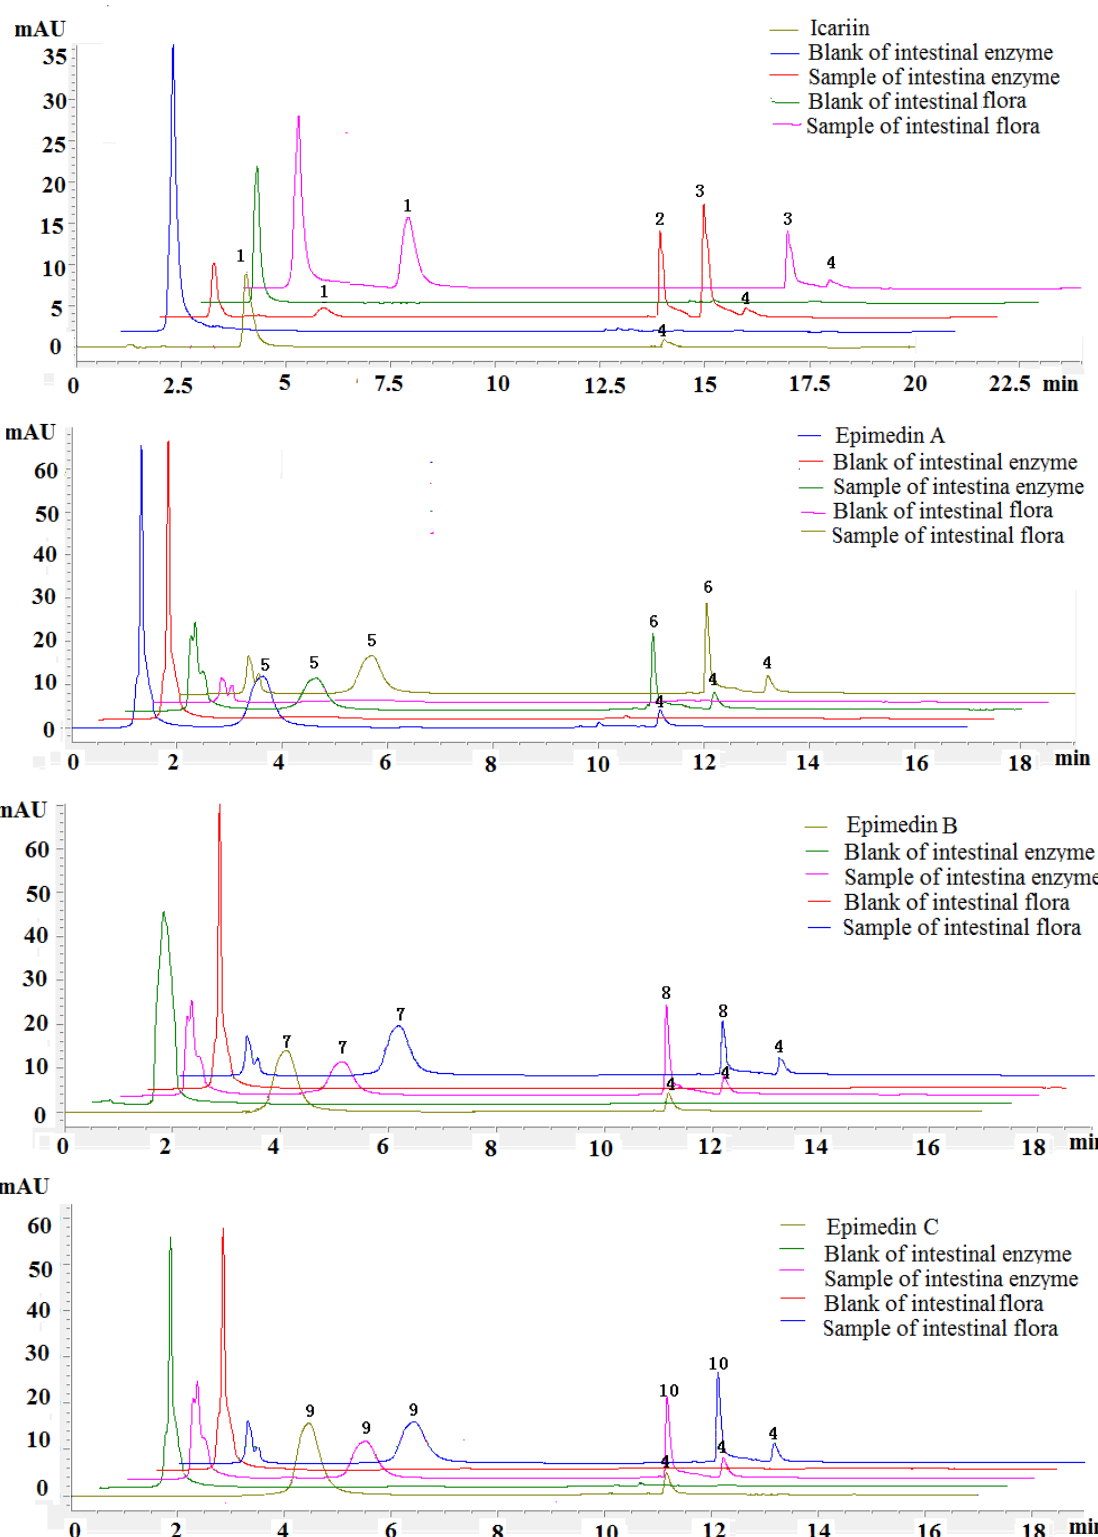
Figure 2. HPLC-UV elution profiles of five prenylfalvonoids and their intestinal metabolites. (1) icariin; (2) M ; (3) baohuoside I; (4) testosterone; (5) epimedin A; (6) M 1 (7) epimedin B; (8) M ; (9) epimedin C; (10) M 4 standard (IS). M , M , M , M were defined as the 1 3 4 5